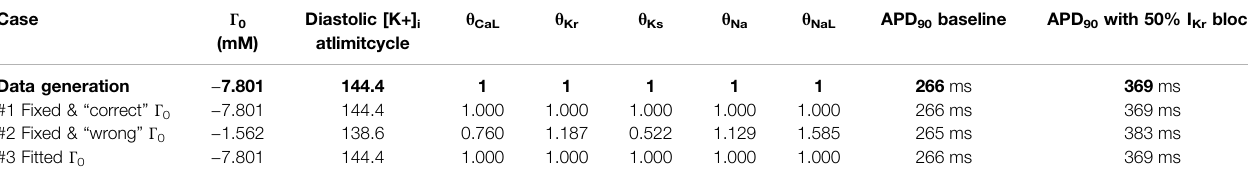
TABLE 3 | Parameters retrieved from fi ttings in the investigated cases. The fi tting process with an incorrect Γ 0 value yields incorrect values for model parameters. Such a model suffers from poor predictive power, this can be corrected by fi tting Γ 0 together with the other model parameters.